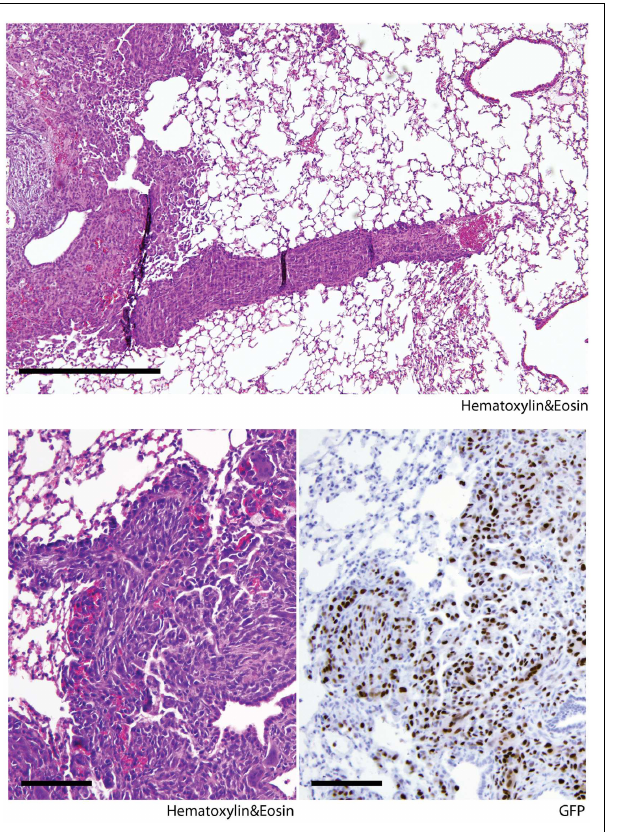
FIGURE 2 | Kras; p16p19 null mouse myogenic tumors metastasize to the lungs of tumor-bearing animals . Random lung sections from Kras; p16p19 null tumor-bearing mice show metastases.Tumor cells invade lung capillaries (top panel). Similar to primary tumors arising from GFP + Kras -expressing; p16p19 null satellite cells, lung metastases are GFP + (bottom right panel). Images were taken at 10 × and 20 × (scale bars indicate 100 µ m)